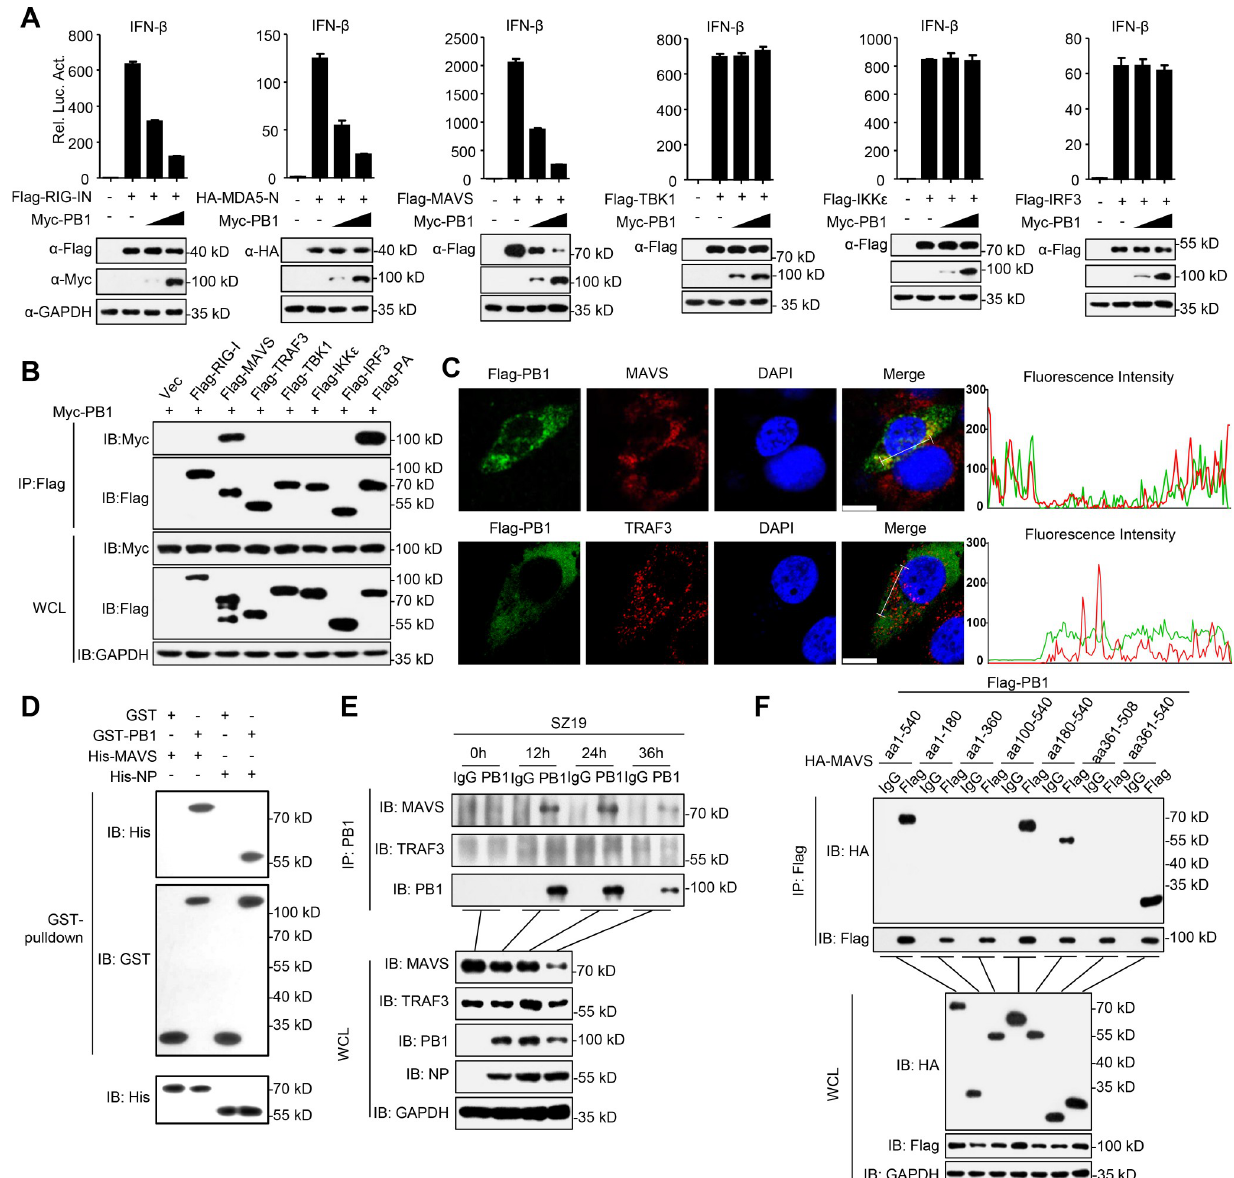
Fig 2. H7N9 PB1 specifically interacts MAVS. (A) PB1 inhibits activation of IFN- β promoter induced by RIG-I-CARD (indicated as RIG-IN), MDA5-CARD (indicated as MDA5-N) and MAVS. HEK293 cells were transfected with the indicated plasmids along with control vector or increased amounts of PB1 expression plasmids. Reporter assays were performed 24 h after transfection. (B) Overexpressed PB1 interacts with MAVS. HEK293 cells were transfected with the indicated plasmids for 24 h. Then the co-immunoprecipitation and immunoblotting analyses were performed with the indicated antibodies. (C) PB1 co-localizes with MAVS in the cell cytoplasm. A549 cells were transfected with a Flag-PB1 plasmid for 24 h, then stained with Flag antibody or MAVS/TRAF3 primary antibody and secondary antibody. The nuclei were stained by DAPI. The fluorescence intensity profile of DAPI (blue), Flag-PB1 (green) and MAVS/TRAF3 (red) was measured along the line drawn by Image J. Scale bars, 10 μ m. (D) PB1 interacts with MAVS directly. Purified GST-PB1 was used to pull down purified His-MAVS. His-NP served as a control. (E) Endogenous PB1 is associated with MAVS. A549 cells were infected with SZ19 virus (MOI = 0.1) for the indicated times before coimmunoprecipitation and immunoblot analysis. (F) MAVS associates with PB1 through its transmembrane domain. HEK293 cells were transfected with the indicated plasmids before co-immunoprecipitation and immunoblotting analysis with the indicated antibodies. The data shown represent three independent experiments; bars represent the mean ± SD of the three independent experiments (n = 3).